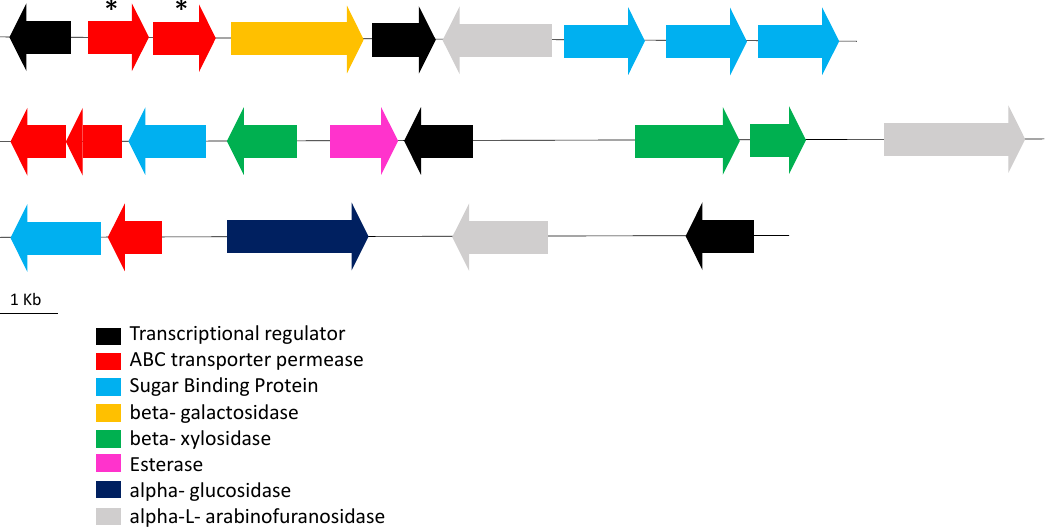
Figure 4. Representation of the different gene clusters containing alpha- L -arabinofuranosidases from family E.C. 3.2.1.55 in the genome of B. longum subsp. longum F8. *, genes not annotated in the genome of the F8 strain, but annotated as “ABC transporter permease” in the genomes of the strains JDM 301, BBMN68, JCM 1217, KACC 91563, and GT15.